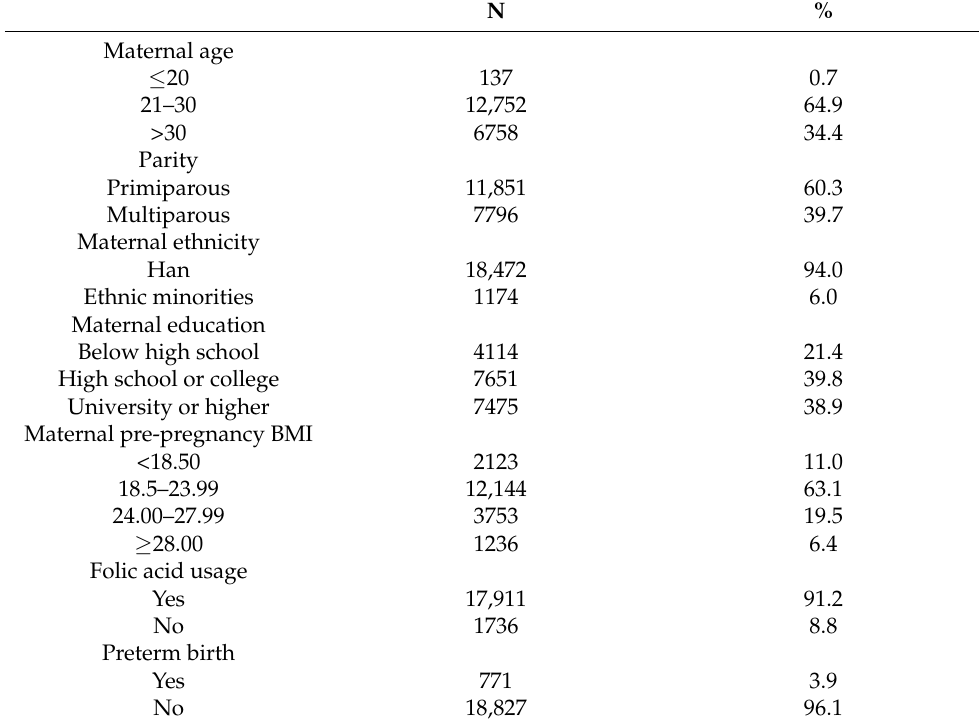
Table 1. Maternal characteristics and birth outcomes (n = 19,647). N